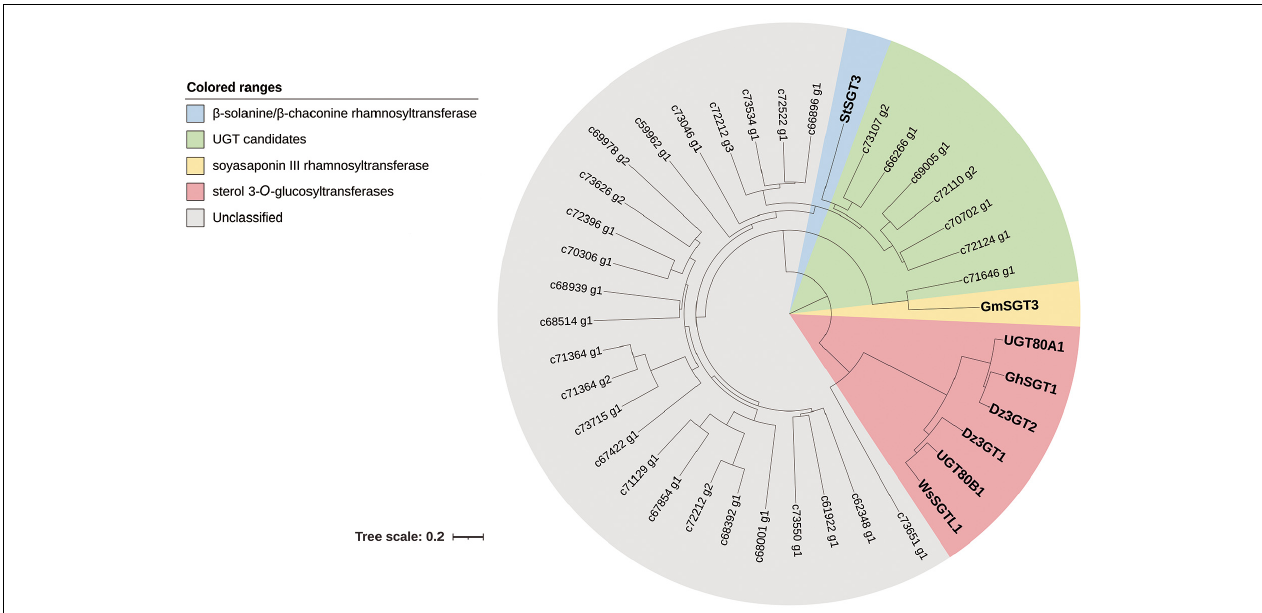
FIGURE 2 | Phylogenetic analysis of the UGT candidates from Dioscorea zingiberensis with other related function known sequences. The tree was constructed by the neighbor-joining method of MEGA 7.0, modified by iTOL, and the bootstrap values was 1,000. The scale bar represents 0.2 amino acid substitutions per site.